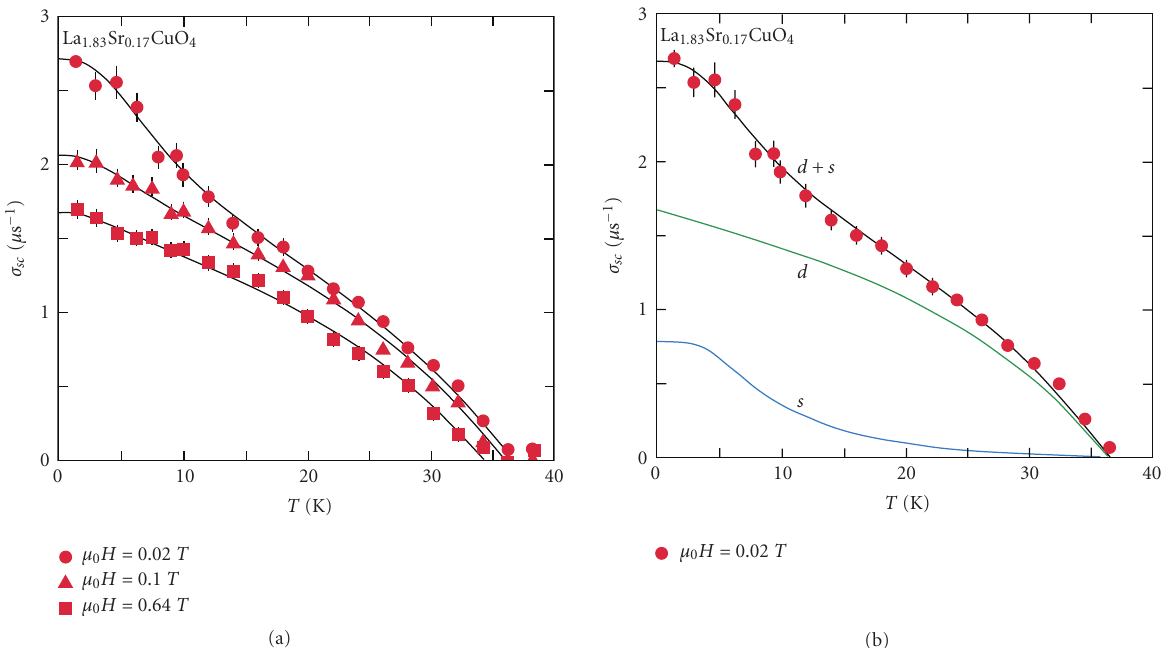
Figure 9: Temperature dependence of the μ SR relaxation rate σ sc ∝ λ − 2 of single crystals of La 1 . 83 Sr 0 . 17 CuO 4 measured at magnetic field ab strengths of 0.02, 0.1, and 0.64 T . Lines in panels (a) and (b) represent calculations using a two-gap model [22–25]. The green and blue lines in panel (b) show the individual contributions from the d - and s -wave gap, after